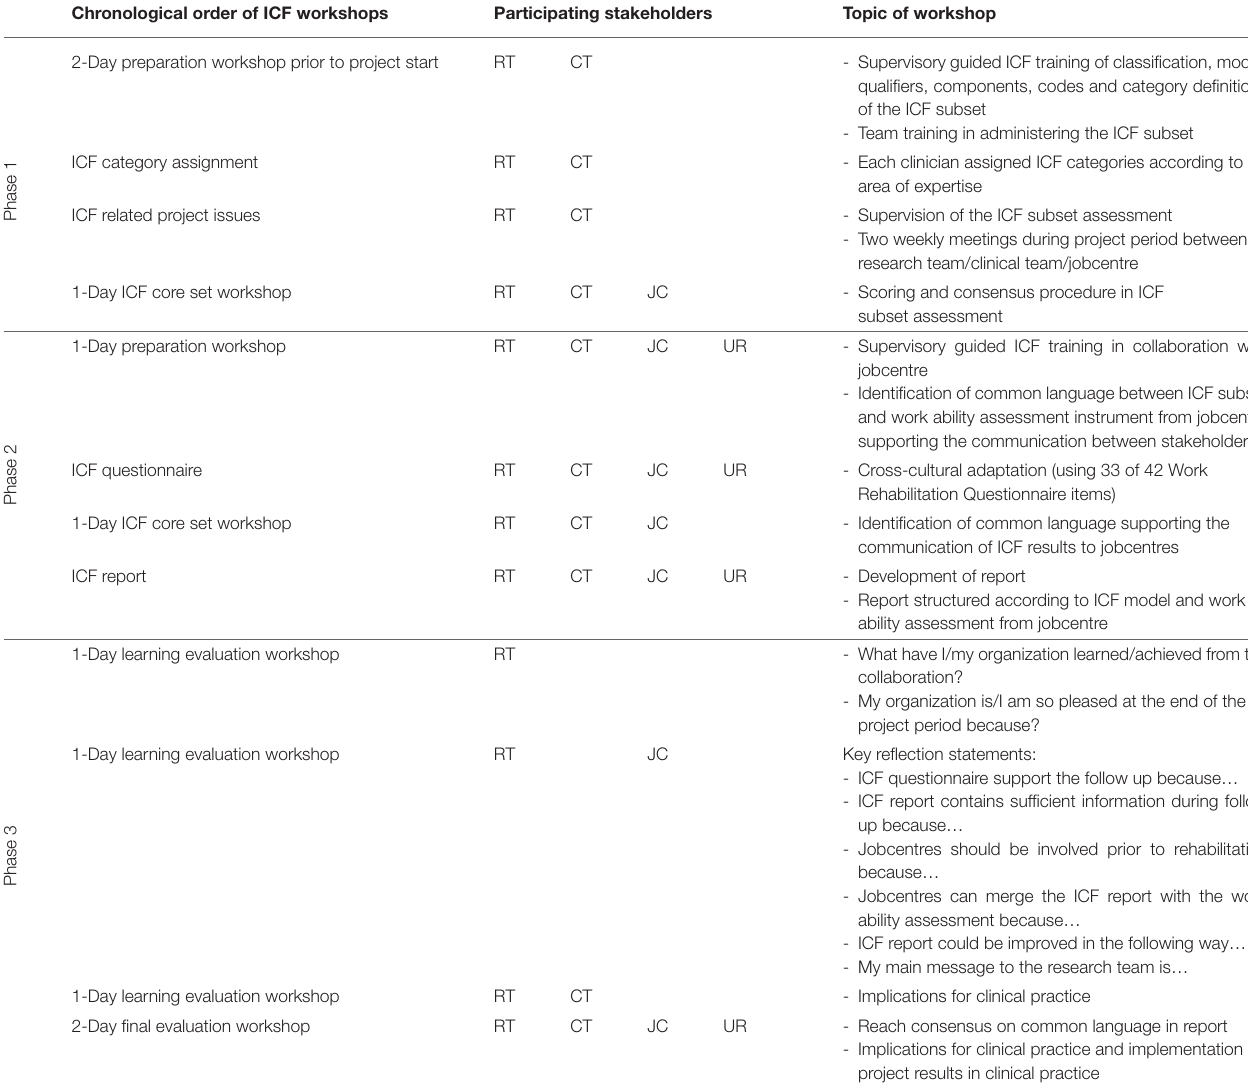
TABLE 3 | Chronological order of ICF workshops and topics including the participating stakeholders [research team (RT), clinical team (CT), Jobcentre (JC), user representative (UR)]. Chronological order of ICF